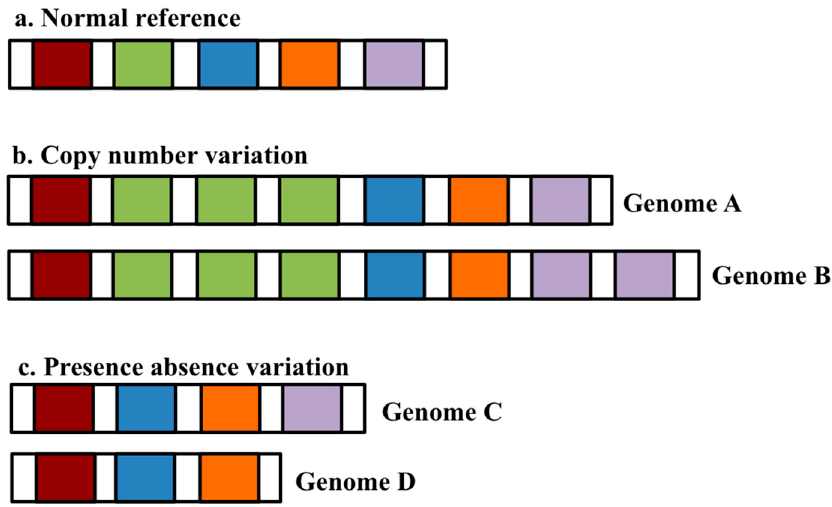
Figure 1. Figure illustrating a normal reference with the correct number of genes represented by coloured blocks (a), copy number variations ( b ) and presence absence variations ( c ).